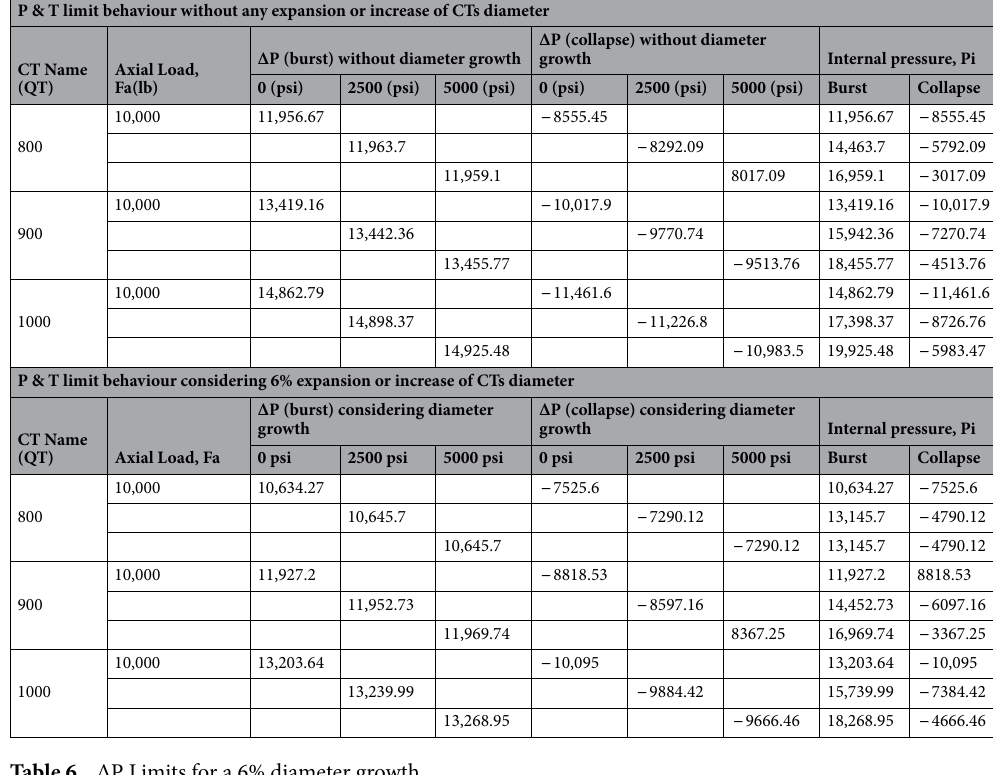
Table 6. ΔP Limits for a 6% diameter growth.